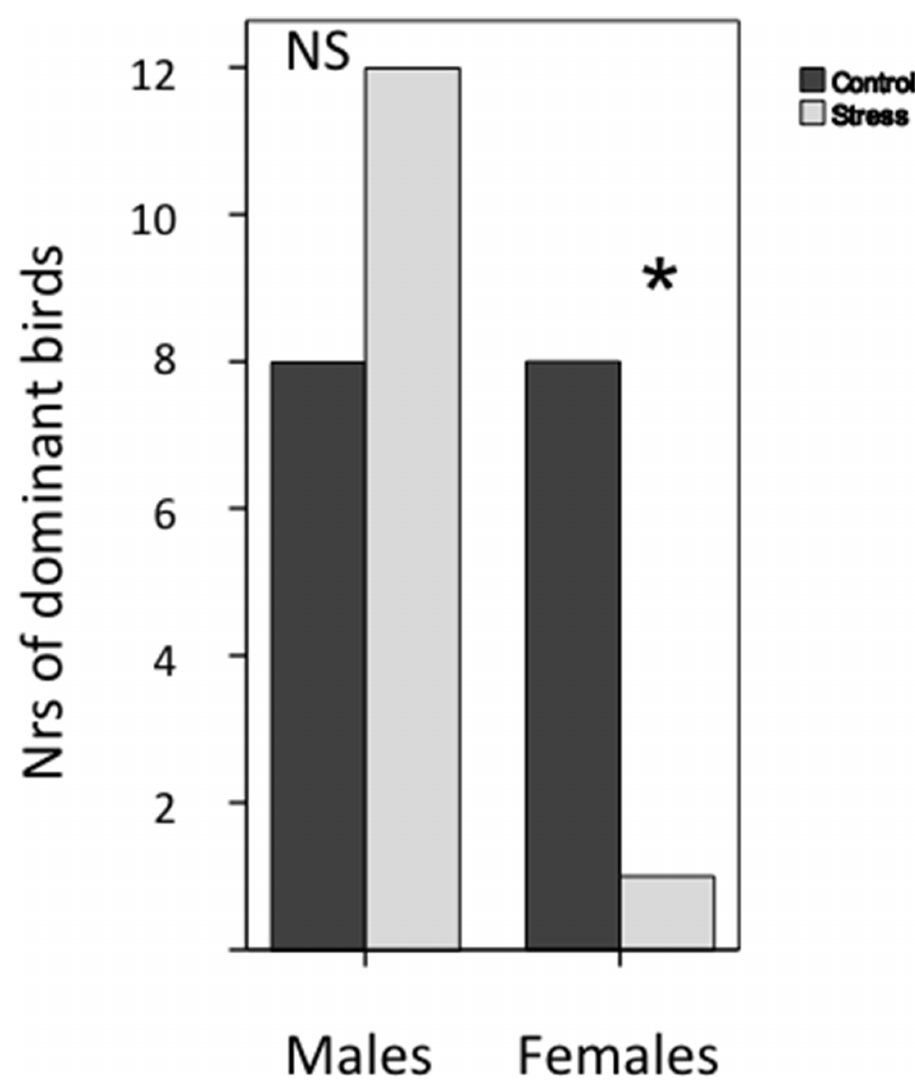
Fig 3. Social dominance in early stressed vs control male (N = 40) and female (N = 18) chickens. The figure shows the number of tested pairs in which either the early stressed or the control bird was scored as dominant. * : P < 0.05, NS = not significant.